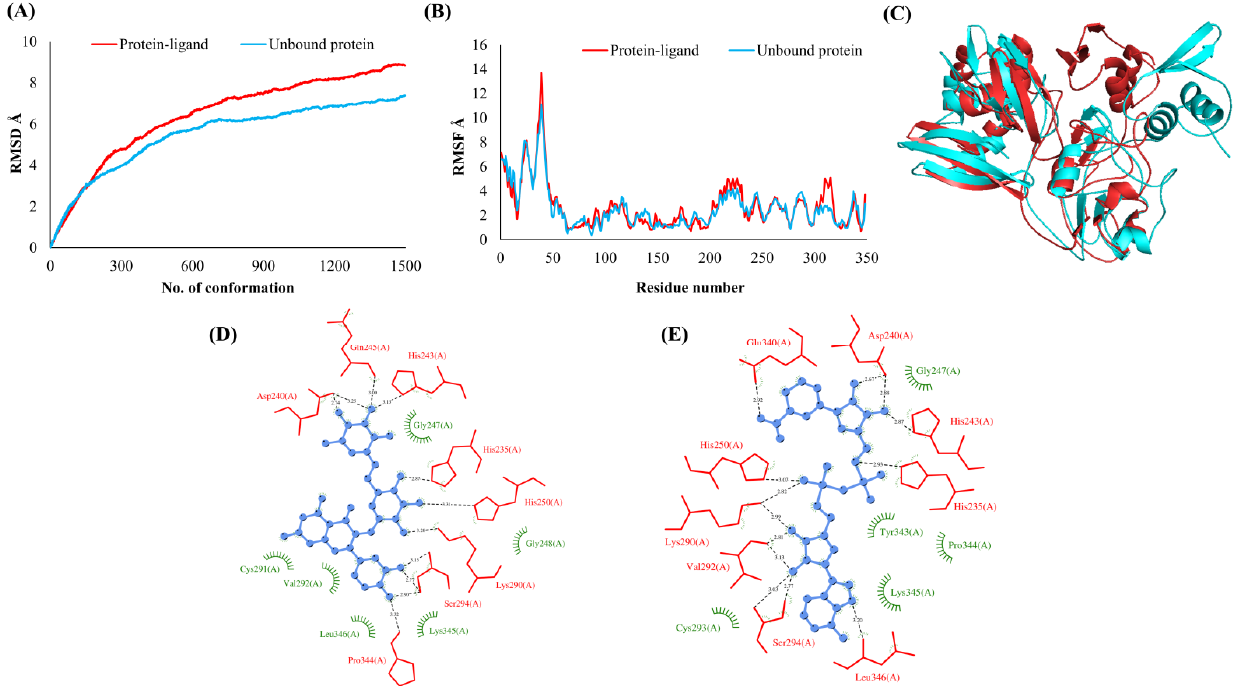
Figure 6. Helicase (NSP13). ( A ) RMSD plot of unbound and ligand-bound protein ( B ) RMSF plot of unbound and lig- and-bound protein ( C ) Superimposition of unbound and ligand-bound protein ( D ) Molecular interactions of protein with Rutin ( E ) Molecular interactions of protein with NADH.